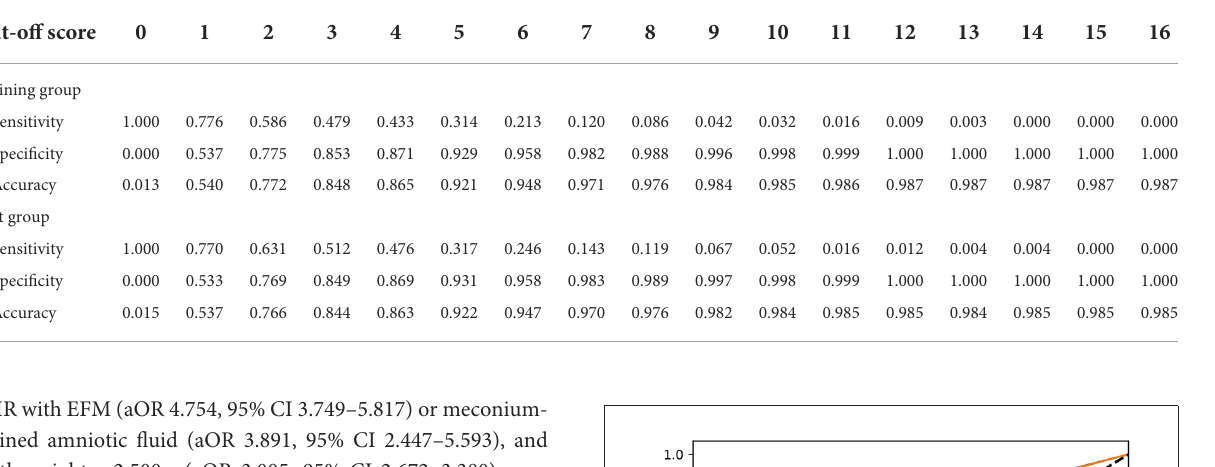
TABLE 6 Sensitivity, specificity and accuracy of different cut-off scores.